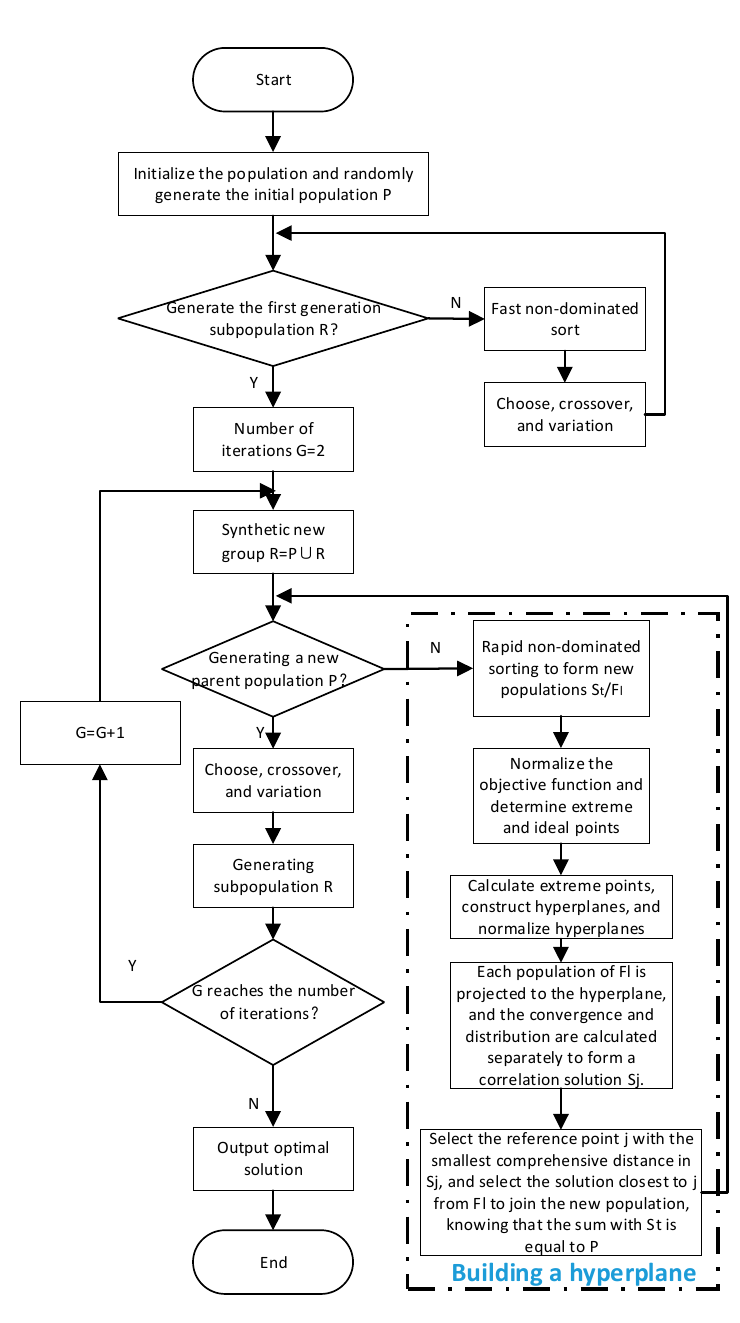
Figure 2. Flow chart of NSGA-III.